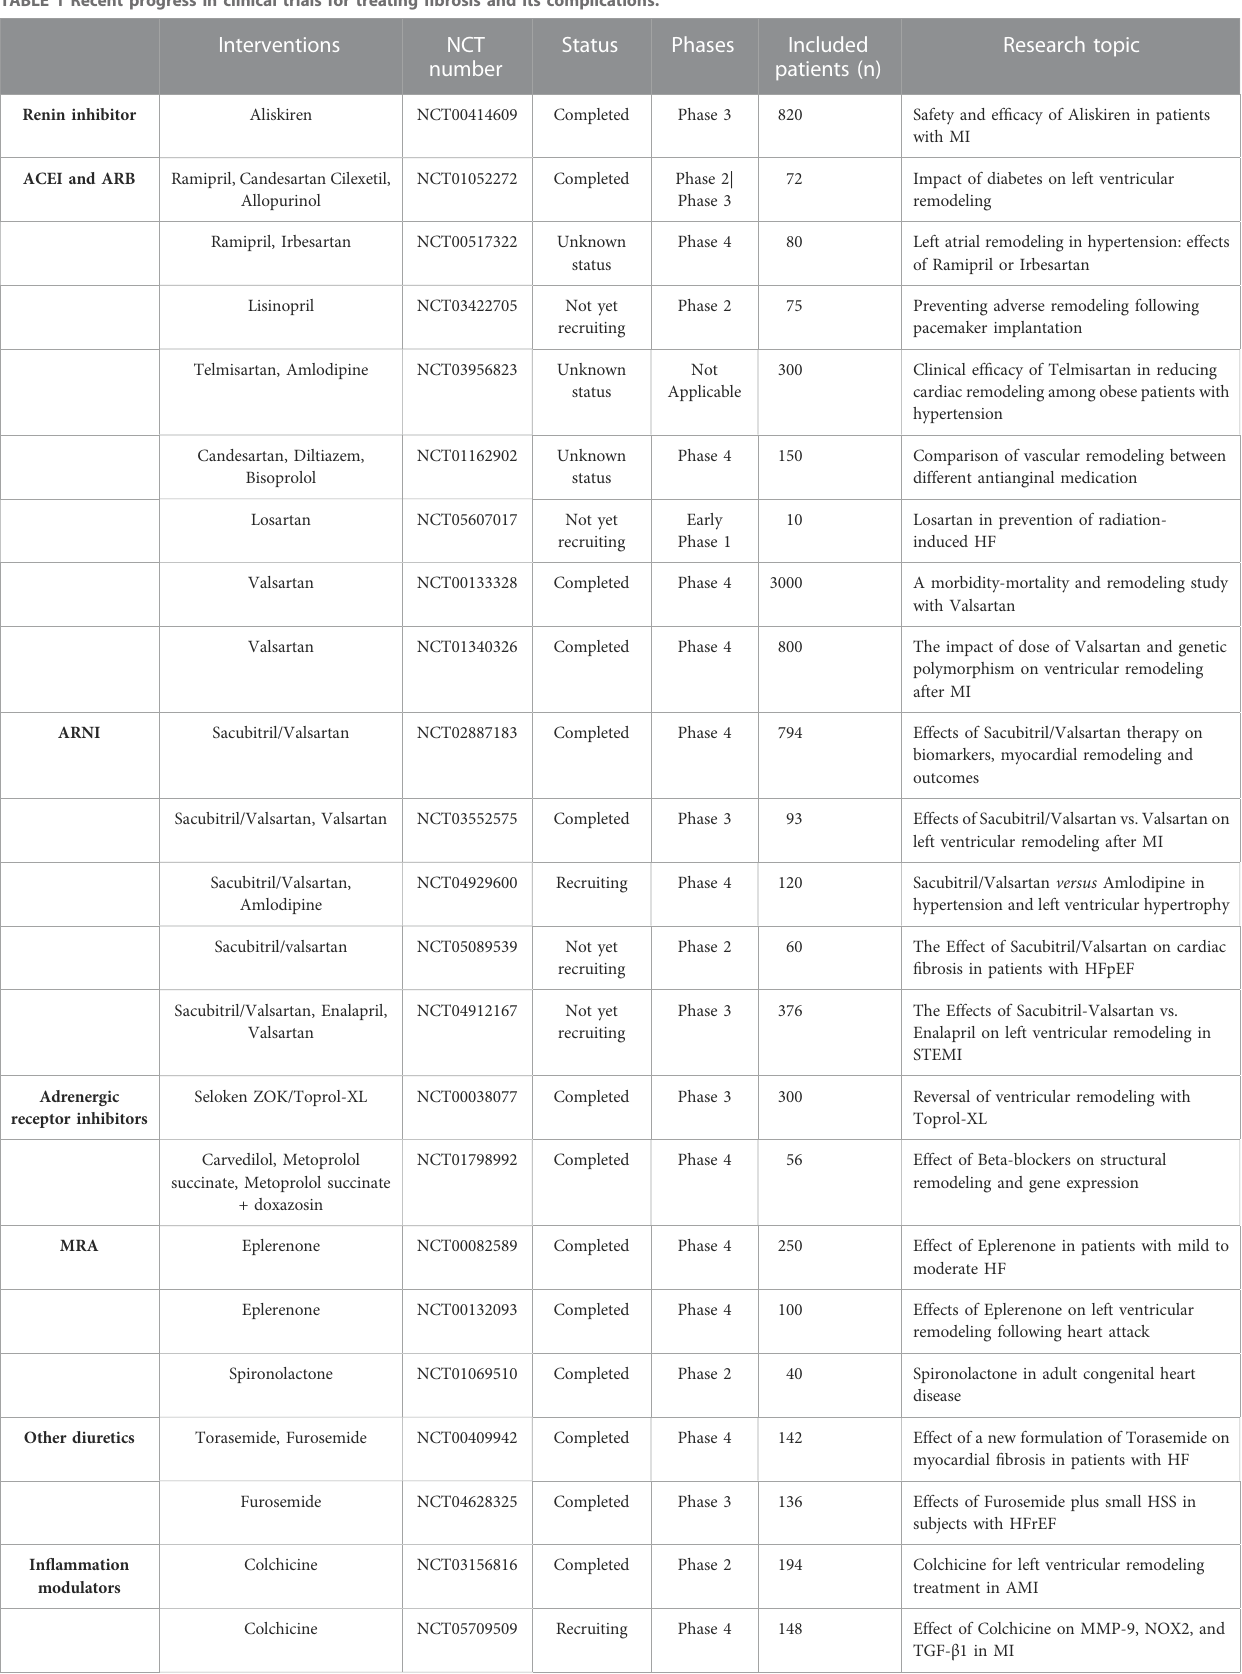
TABLE 1 Recent progress in clinical trials for treating fi brosis and its